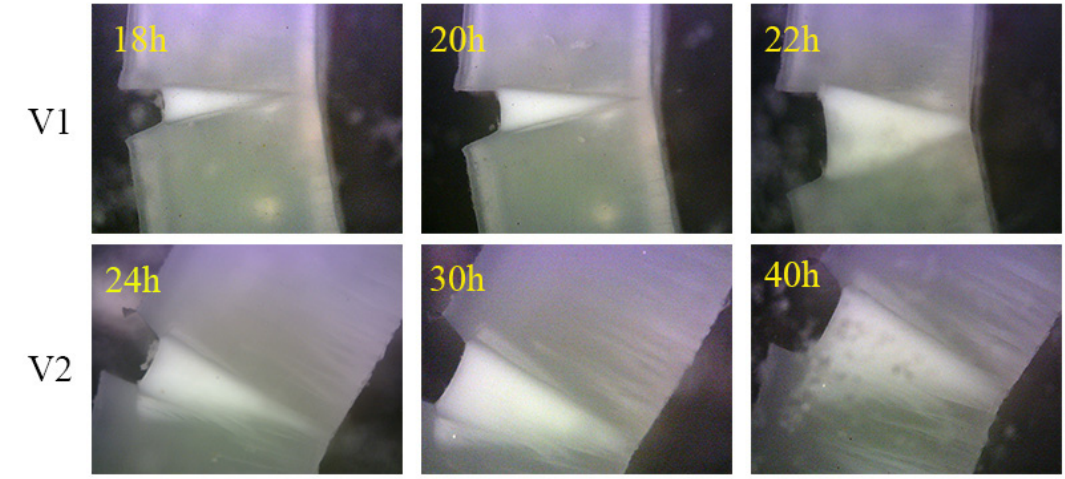
Figure 6. The patterns of crack propagation of sample at the later stage.